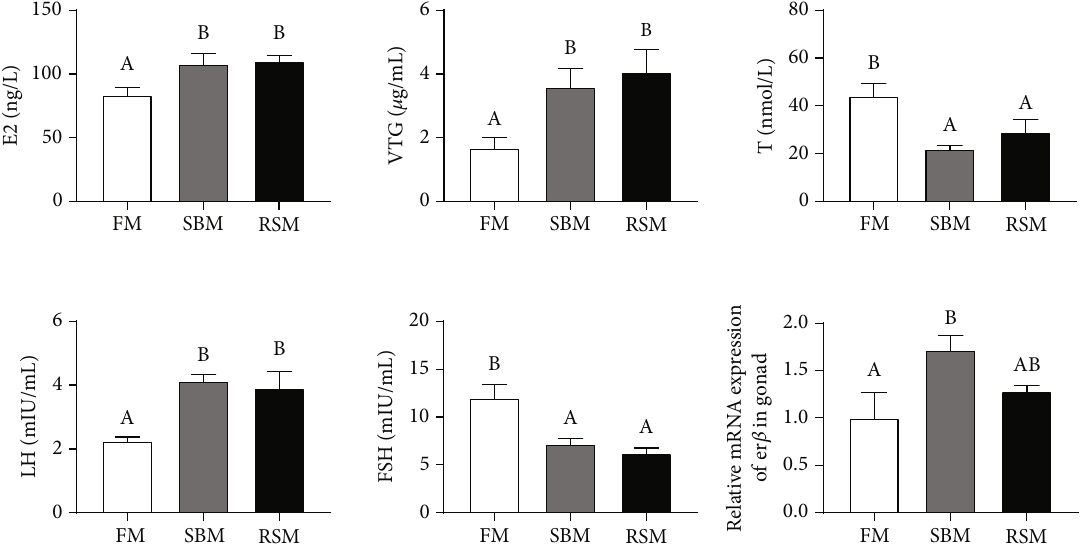
Figure 2: Plasma hormone contents, VTG contents, and relative mRNA expression of gonadal er β of female yellow cat fi sh broodstock fed experimental diets. E2: estradiol; VTG: vitellogenin; T: testosterone; LH: luteinizing hormone; FSH: follicle stimulating hormone. Values are expressed as means ± SE ; di ff erent letters represent the statistically signi fi cant di ff erences ( P < 0 : 05